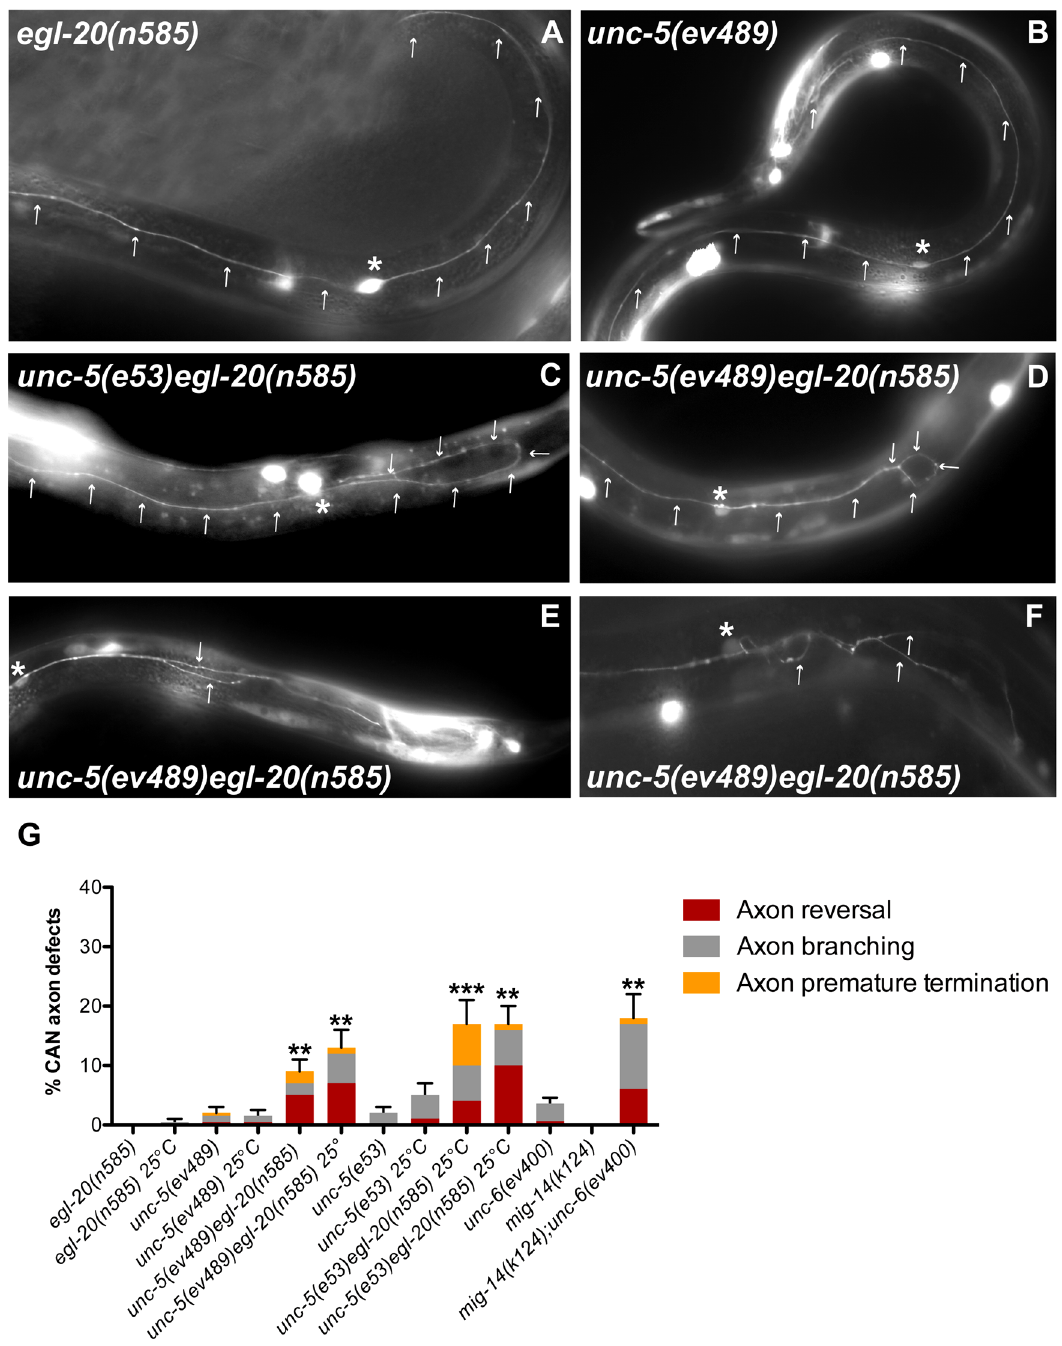
Figure 6. Netrin and Wnt signaling components function redundantly to regulate A/P axon guidance of the CAN neuron. Fluorescence micrographs of the indicated mutant strains bearing gly-18::gfp to visualize the CAN neuron. Dorsal is up and anterior is left. Arrows mark the CAN axon trajectories. Asterisk marks the CAN cell body. (A) egl-20(n585) and (B) unc-5(ev489) both display bipolar axon extensions along the A/P axis as in the wild-type. (C) unc-5(e53) egl-20(n585) as well as (D) unc-5(ev489) egl-20(n585) display axon polarity reversals, as well as axon branching and premature terminations (E,F) All of these defects occur predominantly on the posterior side. (G) Quantification of the CAN axon defects in egl-20 , unc-5 , mig-14/wntless and unc-6 single mutants compared to unc-5 egl-20 or mig-14; unc-6 double mutants, respectively. egl-20(n585) is reportedly temperature sensitive [33] hence the analysis was carried out at both 20 u C and 25 u C. Bars represent the percentage of CAN axon reversals (red), branching (grey), and premature terminations (yellow). The corresponding raw data are presented in Table S6. Error bars indicate standard error of the sample proportion. Comparisons were made to the corresponding single mutant controls. ***P , 0.00001 **P , 0.001.